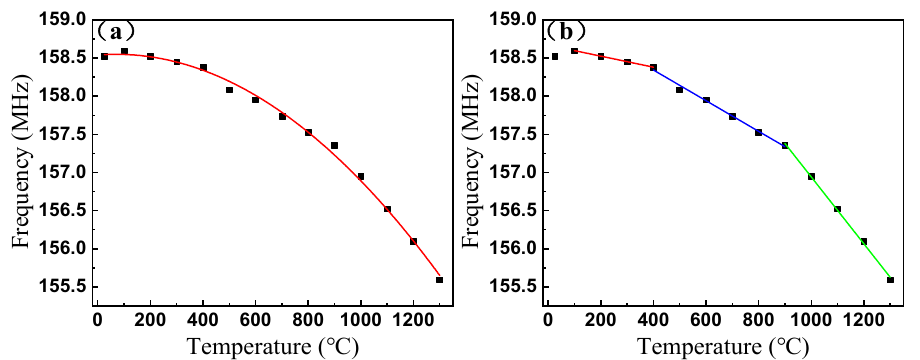
Figure 4. The frequency responsiveness of the SAW sensor during experiment: ( a ) the frequency responsiveness of the SAW sensor during 1300 ◦ C experiment; ( b ) fitting curve for three tempera- responsiveness of the SAW sensor during 1300 °C experiment; ( b ) fitting curve for three tempera- ture ture ranges.